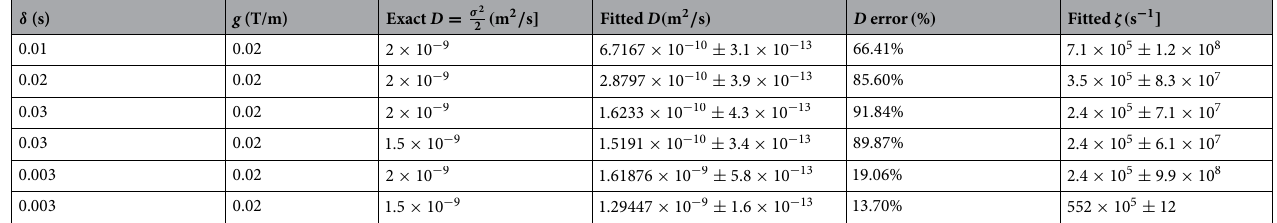
Table 4. Fit parameters of the synthetic curves obtained from VGP trajectories.